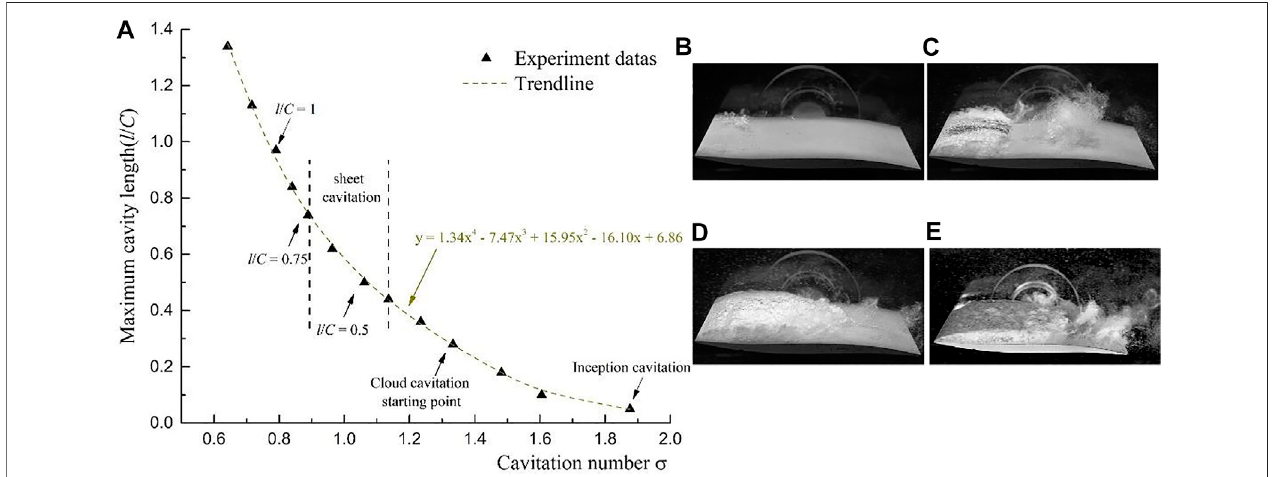
FIGURE 6 | The relationship between cavitation number and cavity length (U ∞ (cid:1) 9 m/s, α (cid:1) +6 ° ).